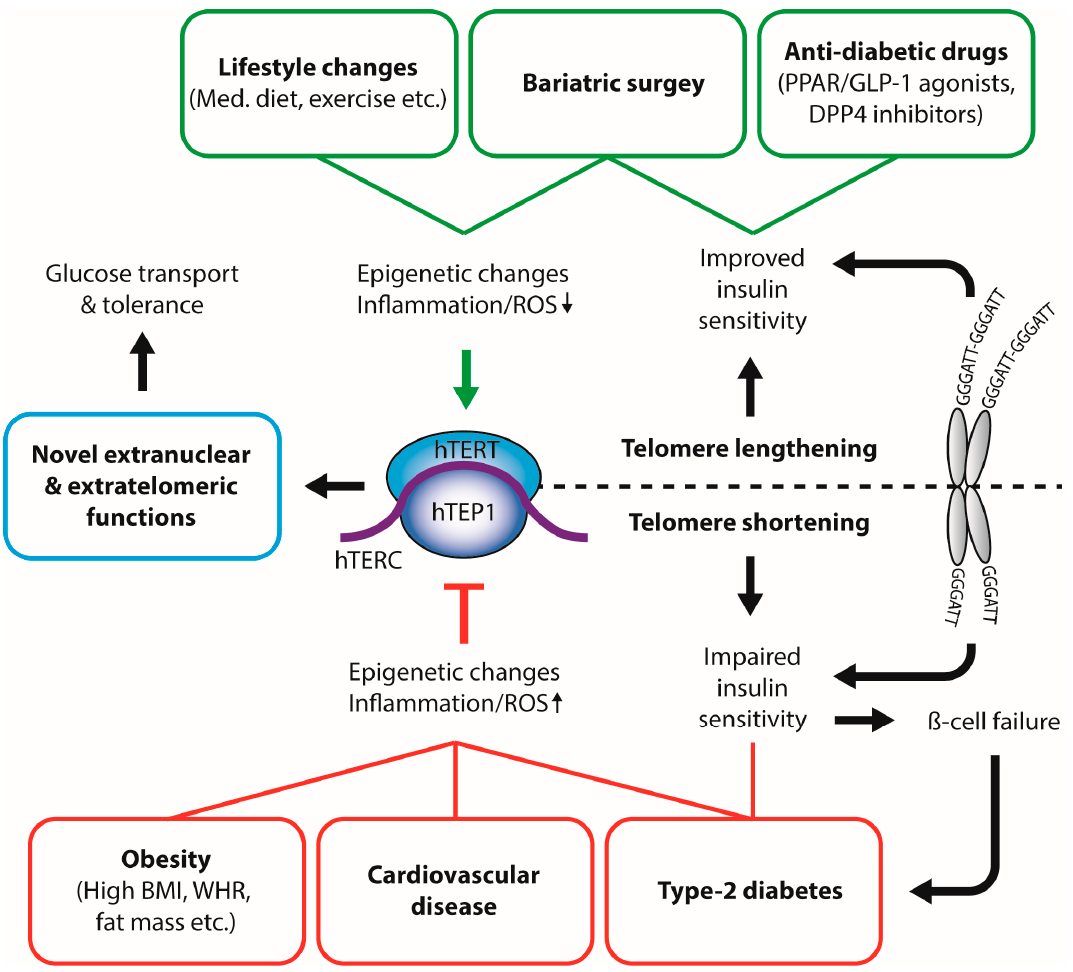
Figure 1. Interplay between physiological and pathophysiological metabolic states and telomerase activity. Dietary compounds, healthy lifestyle, and anti-diabetic therapies inhibit telomerase activity and lead to increased leukocyte telomere length (LTL). In contrast, obesity, increased fat mass, and type-2 diabetes result in decreased leukocyte telomere length, possibly through oxidative stress and inflammatory pathways. Telomere length can directly influence insulin sensitivity. BMI: body mass